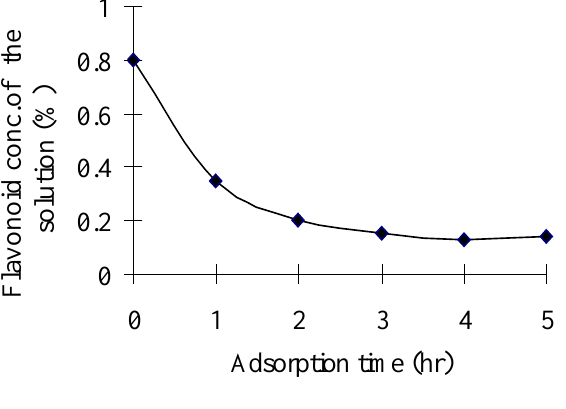
Figure 3 . Influence of time on the resin adsorption of flavonoids.